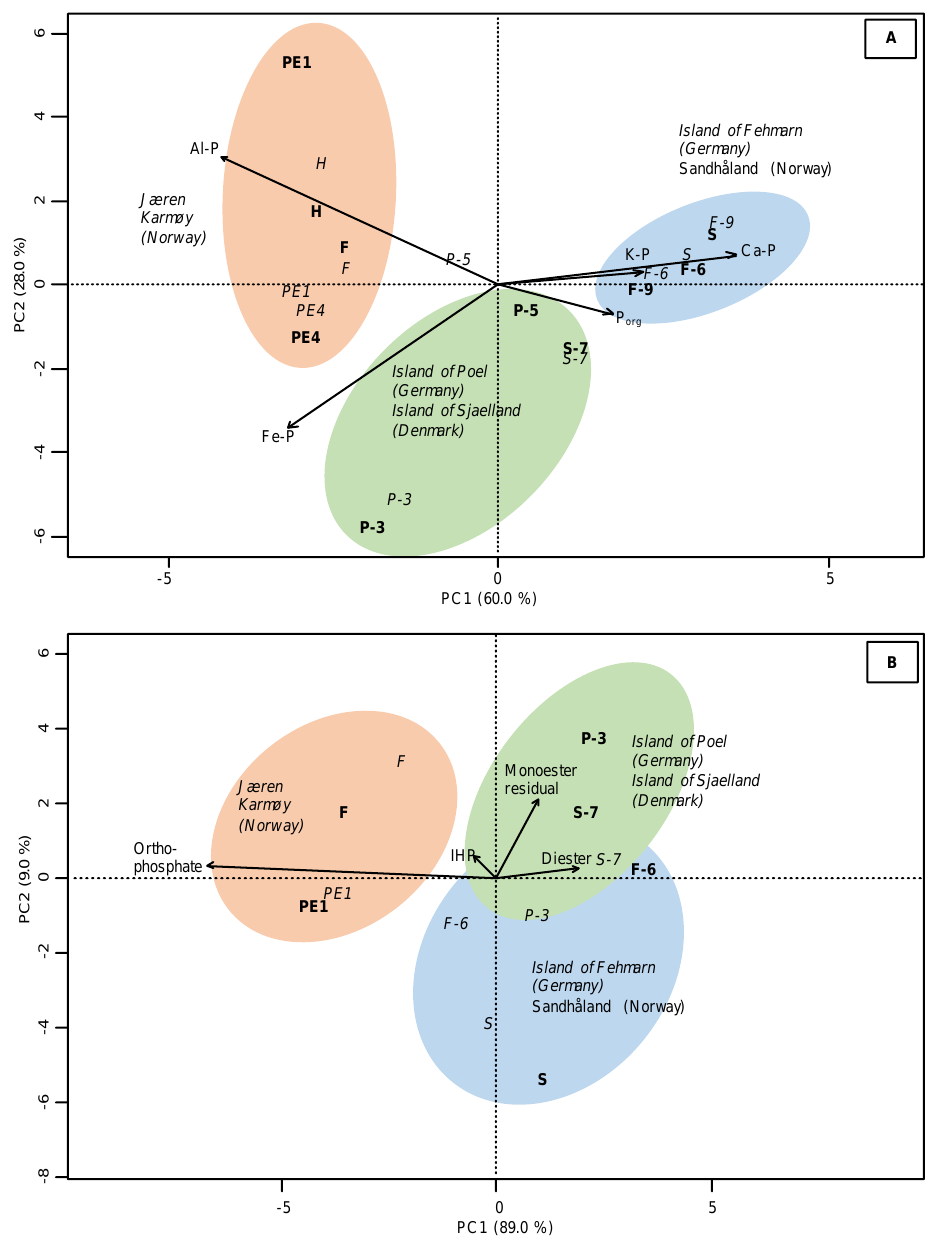
Figure 5. PCA score plot of the proportions of the P species from P K -edge XANES of 10 Northern European soil profiles (F, H, S, PE1, PE4, S-7, F-6, F-9, P-3, P-5) (data in Table 3) ( A ) and of the proportions of the P species from 31 P-NMR of 6 Northern European soil profiles (F, S, PE1, S-7, F-6, P-3) (data in Table 4) ( B ). The upper horizons are represented in italics and underlying horizons as bold symbols. Differently colored areas represent clusters of soils according to their P composition; arrows indicate the presence of specific P-compounds in the soil samples as detected by P K -edge XANES and 31 P-NMR (arrow direction shows direction of P-compound enrichment; arrow length shows intensity of enrichment).